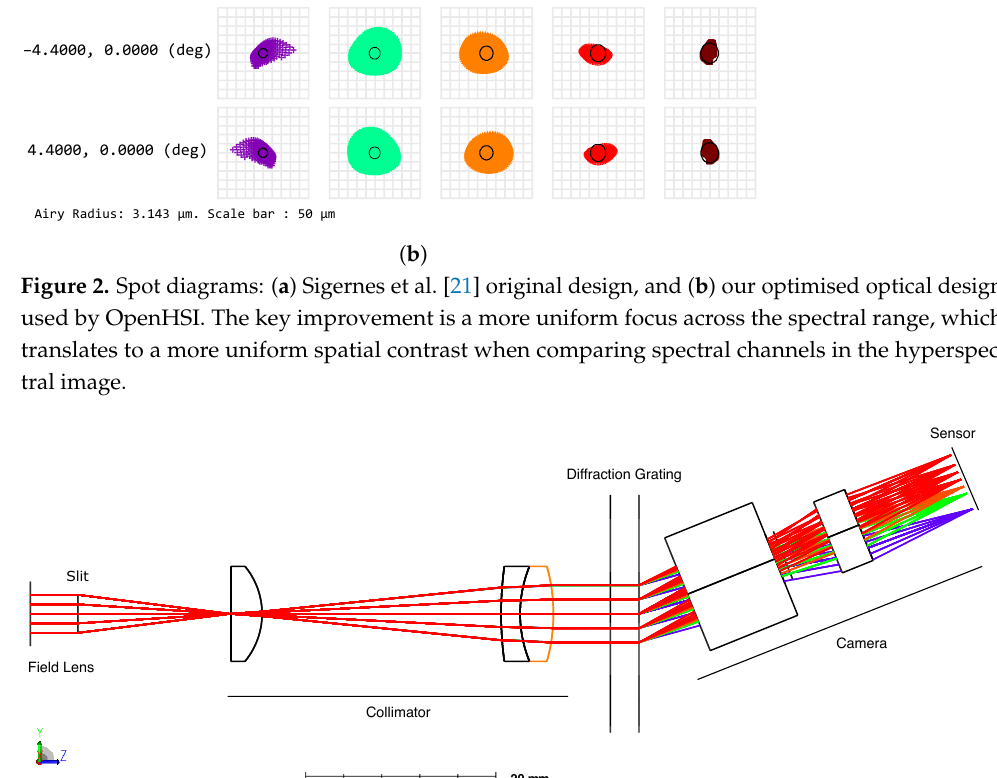
Figure 3. Zemax ray trace of the OpenHSI optical design. The component stages are